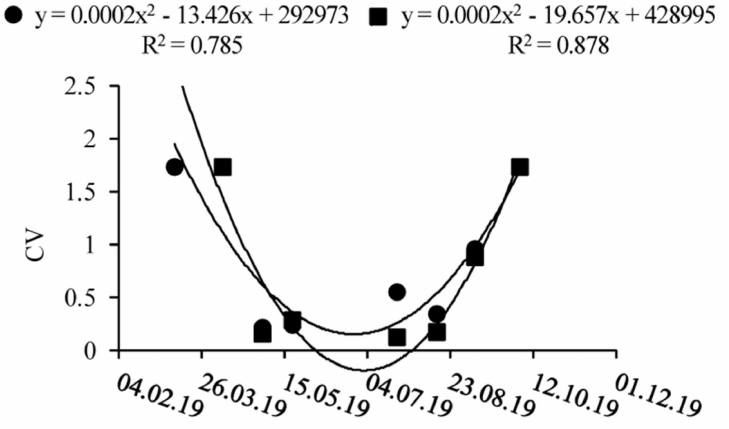
Figure 5. Seasonal changes in the coefficients of spatial variation (CV) in the abundance of Palaemon adspersus females (circles) and males (squares) in the hypersaline Lake Moynaki during 2019. In males and females, the CV significantly (R = − 0.890, p = 0.005) negatively correlated with the abundance of prawns. A significant positive correlation was noted between the changes in the total number of adult prawns (at the stations where they were) and the number of Ruppia (R = 0.940, p =